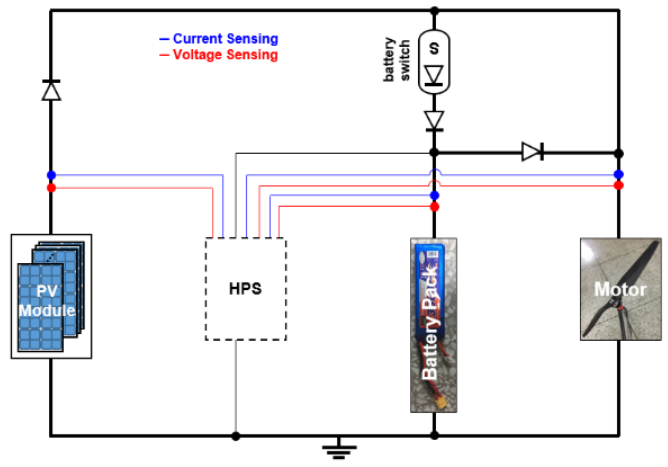
Figure 3. Conceptual electrical interconnection diagram of the HPC.